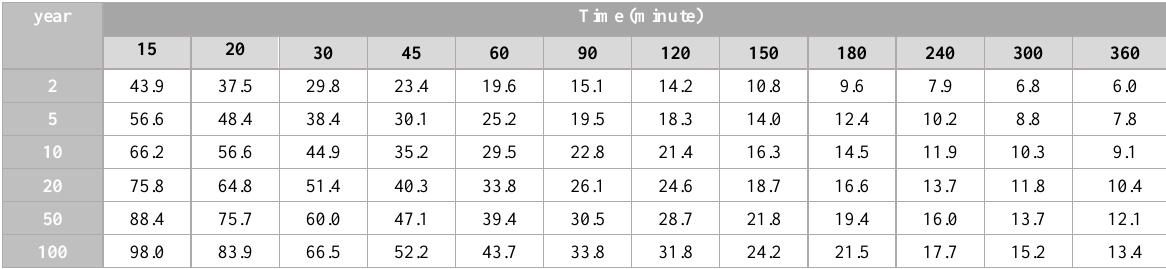
Table 1. Rainfall intensity-duration-frequency table (Malekshahi, 2014).